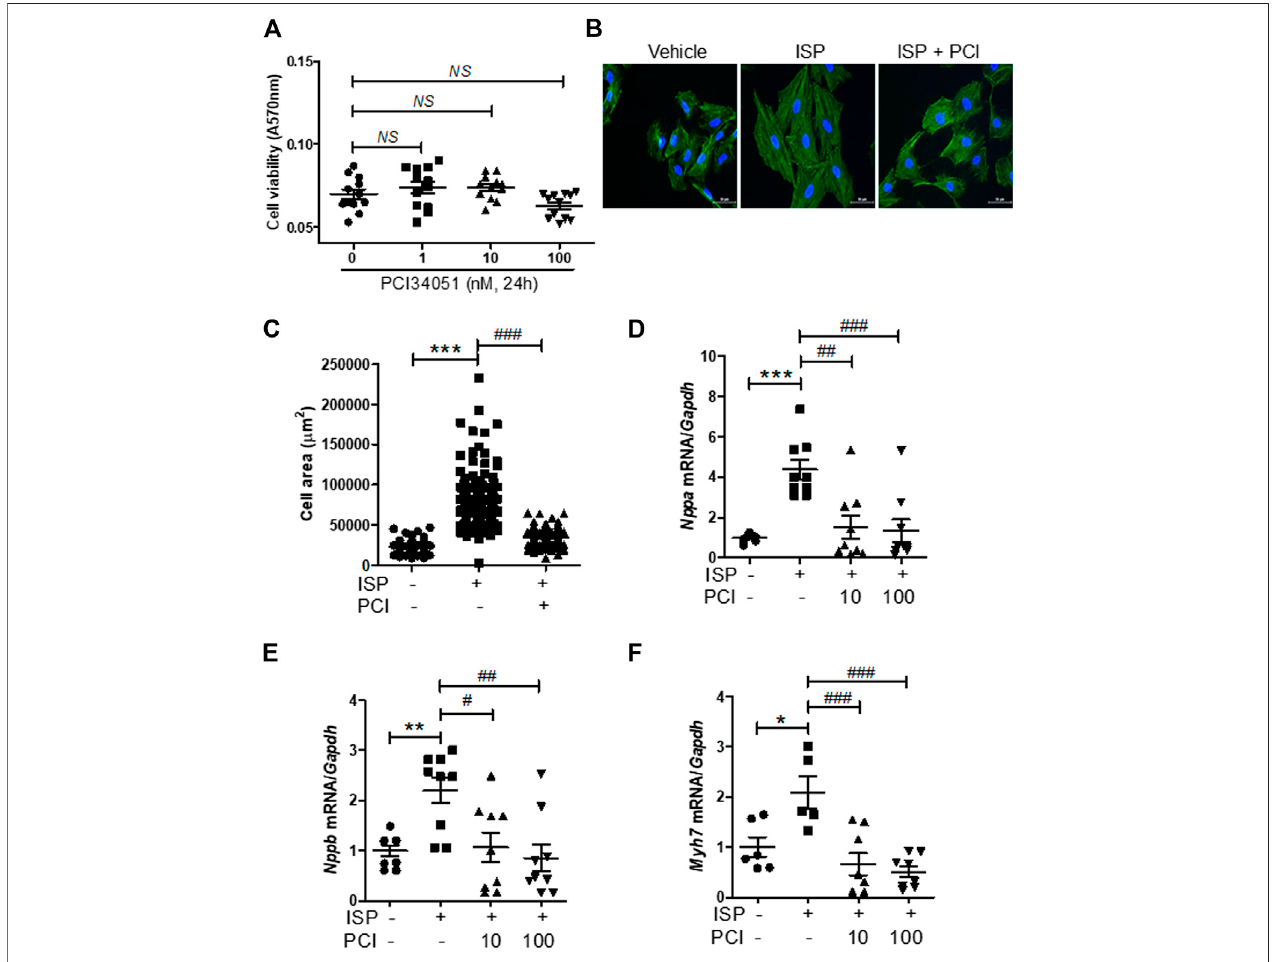
FIGURE 3 | HDAC8selectiveinhibitorattenuatesisoproterenol-inducedcardiachypertrophyinH9c2cells (A) H9c2cellsweretreatedwithvariousconcentrationsofPCI34051 for 24 h and cellviability was evaluated ( n (cid:2) 12). NS (cid:2) not signi fi cant (B) H9c2cellswere seeded in 12-wellplates and serum starved overnight. Cells were treated with isoproterenol (10 μ M)for24 hinthepresenceofPCI34051(100 nM)orvehicle(DMSO).Phalloidinstainingwasperformedtodeterminecellsize.Representativeimages (B) andquanti fi cationofcell size (C) areshown( n (cid:2) 88 – 142).Scalebar (cid:2) 50 μ m*** p < 0.001;### p < 0.001 (D − F) H9c2cellswereserumstarvedovernightandtreatedwithvehicleorisoproterenol(10 μ